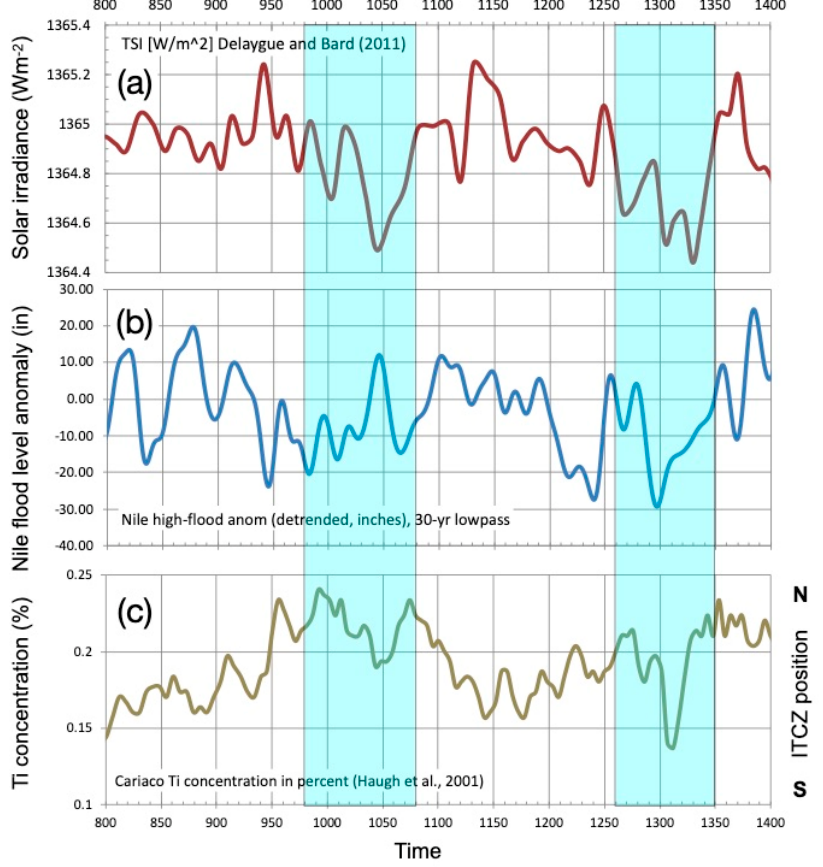
Figure 7. The relationship between ( a ) solar irradiance variations (from [64], in Wm − 2 ), ( b ) Nile River summer flood level deviation from average at Roda Island, Cairo, Egypt (in inches) and ( c ) the concentration of Titanium (Ti, in %) in a sediment core extracted from the Cariaco Basin on the northern shelf of Venezuela (see [91]). In ( c ) we indicated along the right ordinate, the relation between Ti and the position of the ITCZ as argued in [91]. The transparent blue ribbons mark the time of the Oort and Wolf Grand Solar Minima). Time is in calendar years C.E.